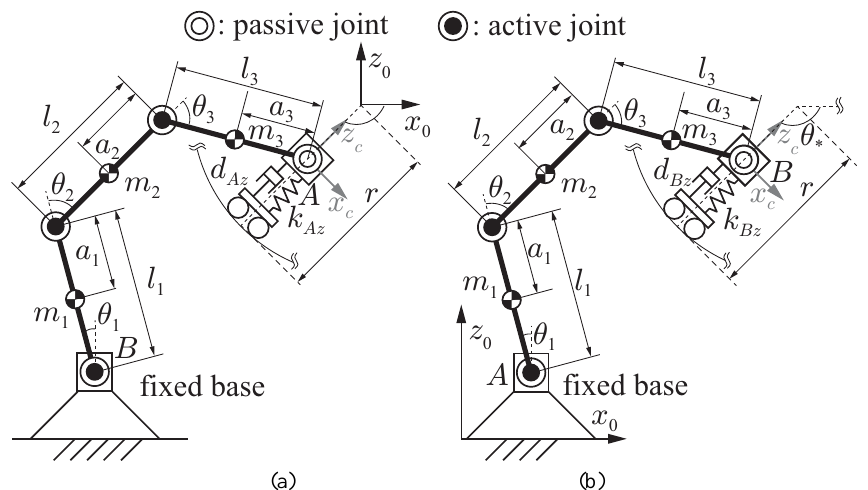
Figure 9. Equivalent planar five-link four-joint manipulator models used in: (a) RNS and (b) Operational Space formulations. In (a) , the “root” link is end-link A (the end-e ff ector); In (b) , the “root” link is end-link A (the base). The passive joint at the end-link appears since the end-link orientation is ignored.